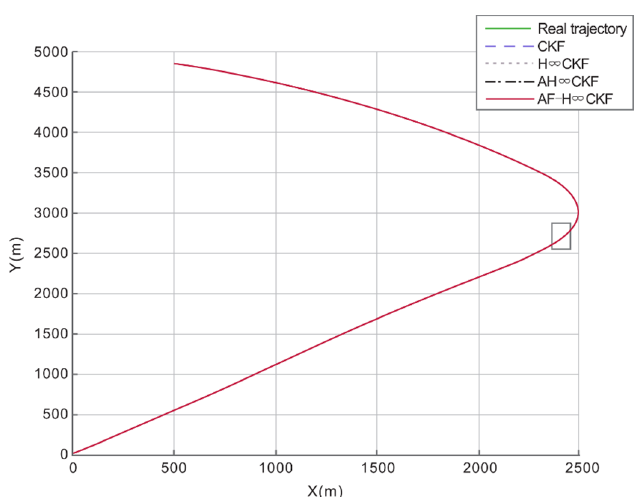
Figure 8. Trajectory in Case 2.